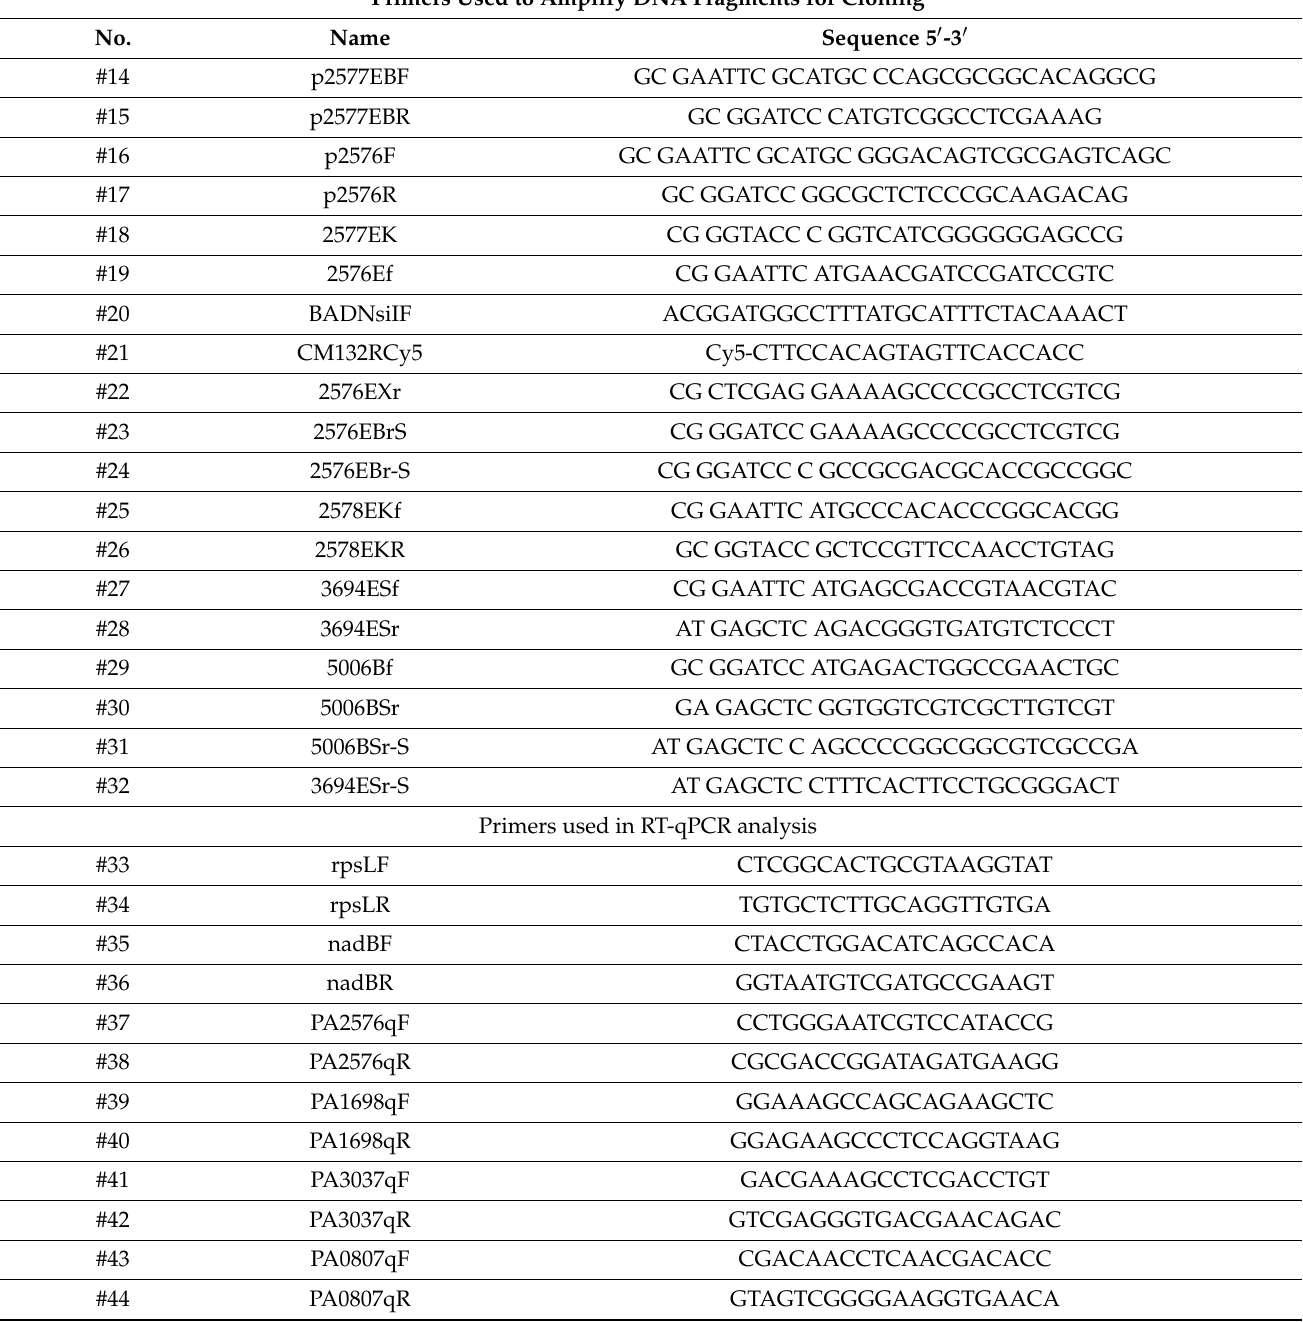
Table A2. Cont. Primers Used to Amplify DNA Fragments for